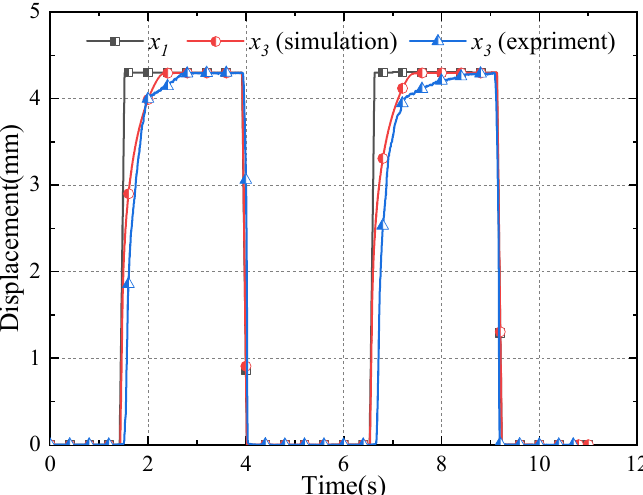
Figure 8. Step response test under 14 MPa.